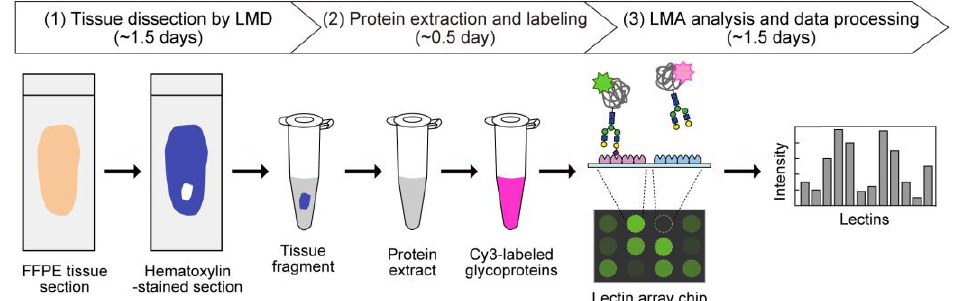
Figure 1. Schematic overview of tissue glycomic profiling by the LMD–LMA method. This method consists of three main steps: (1) tissue dissection from hematoxylin-stained FFPE tissue sections by LMD, (2) extraction and fluorescent labeling of protein samples, and (3) LMA analysis and data processing to obtain glycomic profiles.